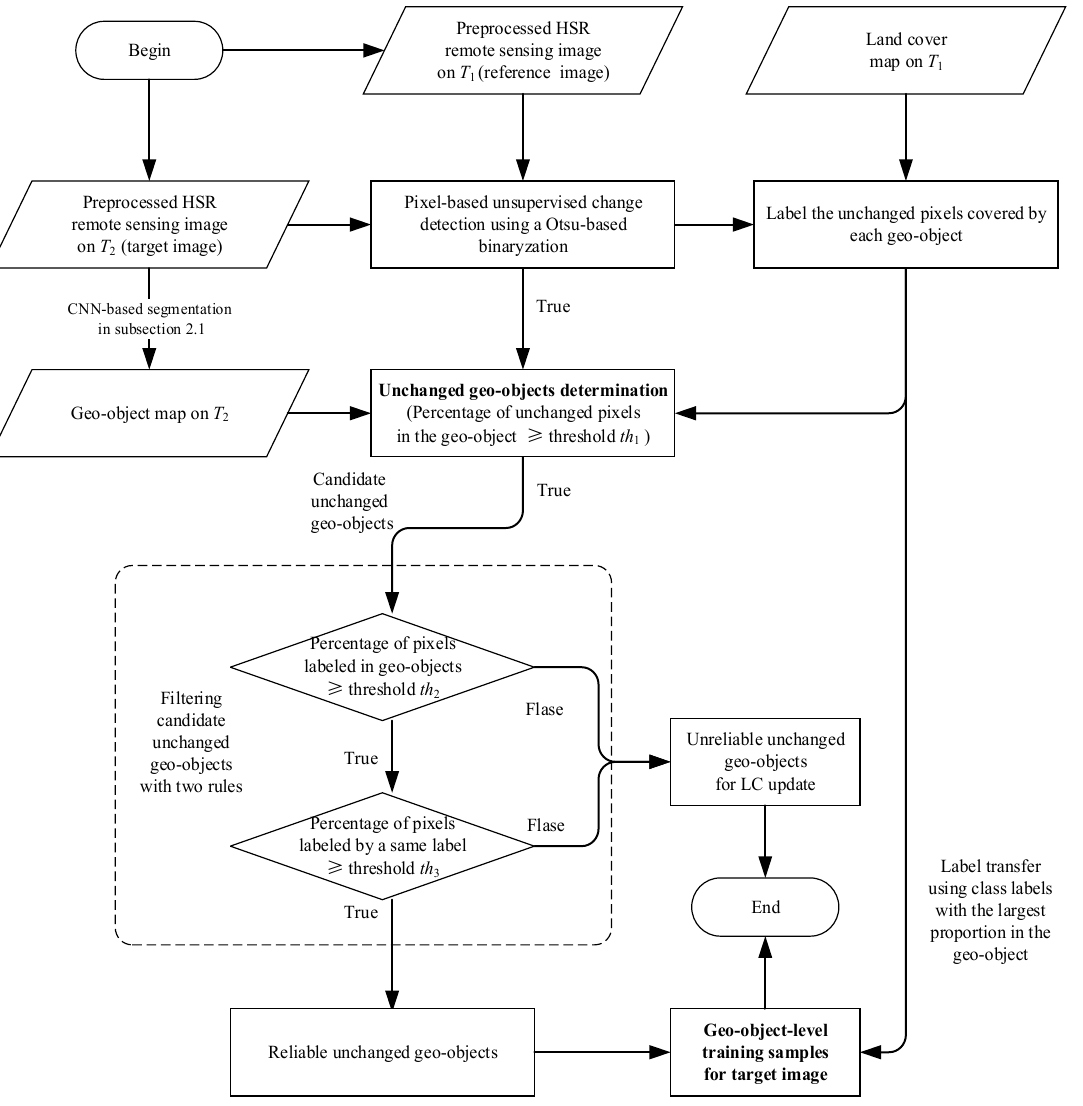
Figure 6. Flow chart of the automatic scheme for geo-object sample collection using a historical land cover (LC) map.